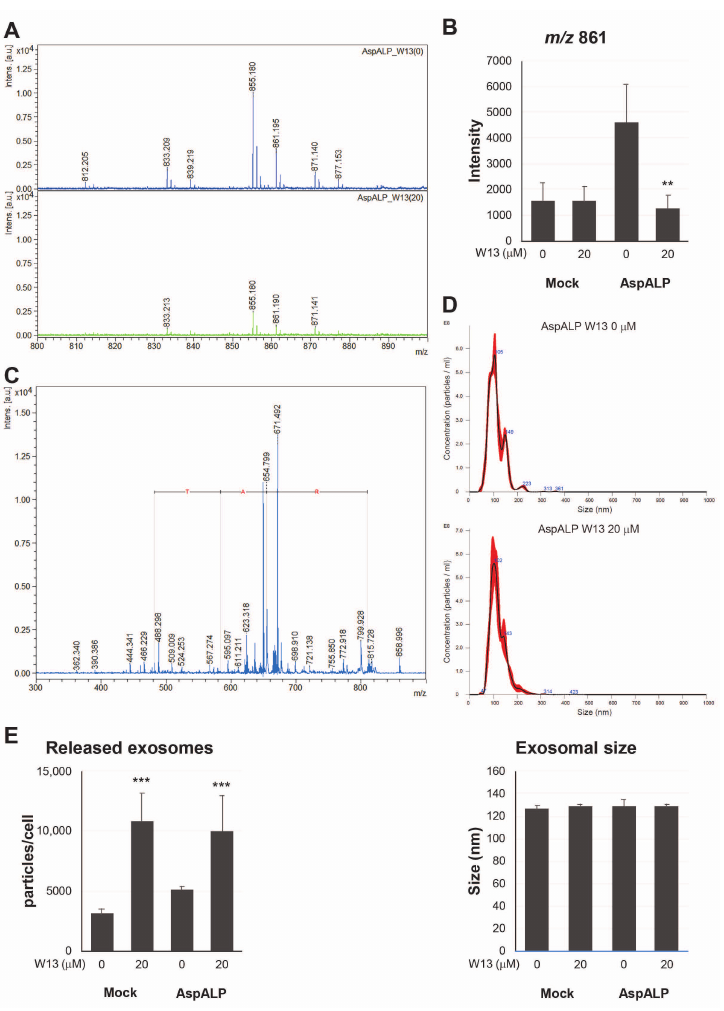
Figure 2. Properties of exosomes from T-REx cells in the absence or presence of W13. ( A ) The peptide solution extracted from the exosomes of T-REx AspALP (AspALP) cells at 0 or 20 µ M W13 for 72 h was analyzed by MALDI-TOF-MS. ( B ) The peak intensity at m/z 861 was measured by MALDI-TOF-MS. ** p < 0.01 vs. AspALP cells at 0 µ M W13. ( C ) MS/MS analysis of peaks at m/z 861 ± 4. ( D ) The upper and middle panels show representative profiles of exosomes from AspALP cells at 0 or 20 µ M W13 for 72 h. The lower panel shows the average size of exosomes released from T-REx Mock (Mock) and AspALP cells at 0 or 20 µ M W13 for 72 h. ( E ) Released exosomes per cell. *** p < 0.001 vs. Mock cells at 0 µ M W13.